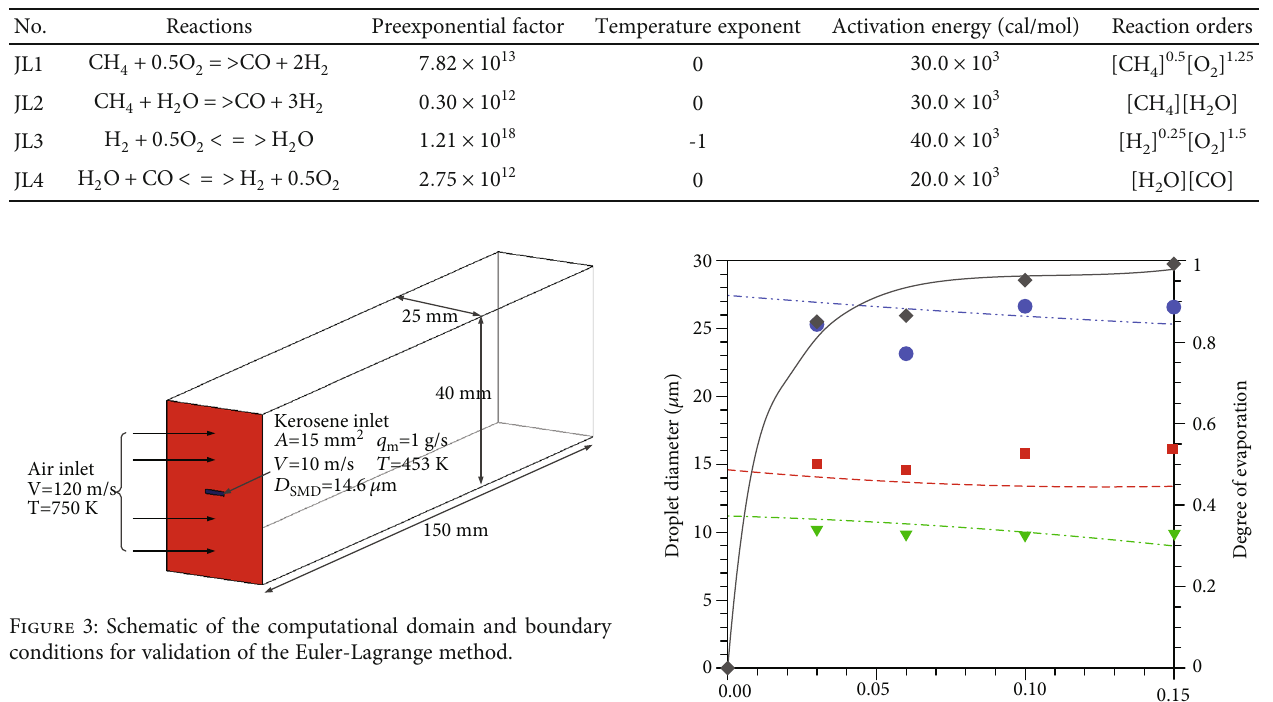
Table 3: Jones-Lindstedt global multistep methane combustion mechanism [37].